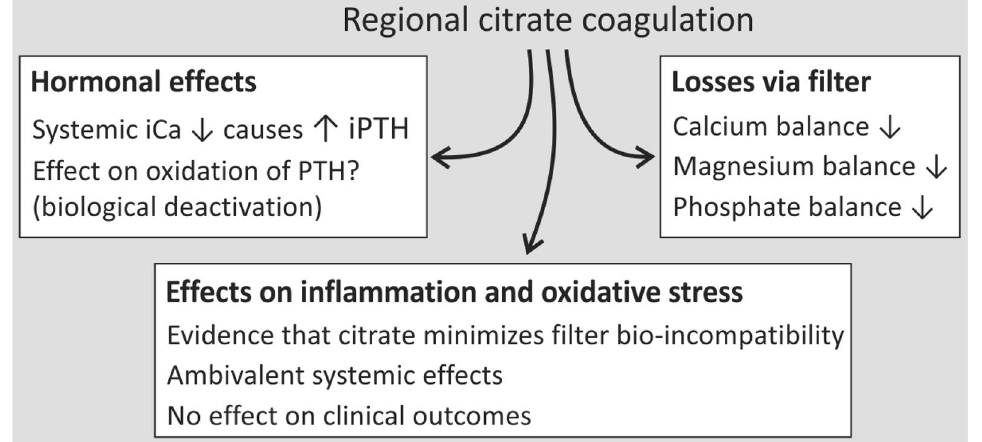
Fig. 2 Unapparent systemic effects of RCA in